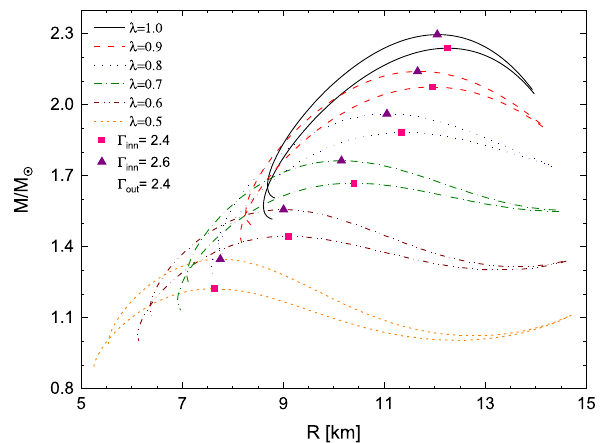
Fig. 3 Total mass as a function of the radius for four values of λ , ρ dis = 8 × 10 17 [ kg / m 3 ] , Γ inn